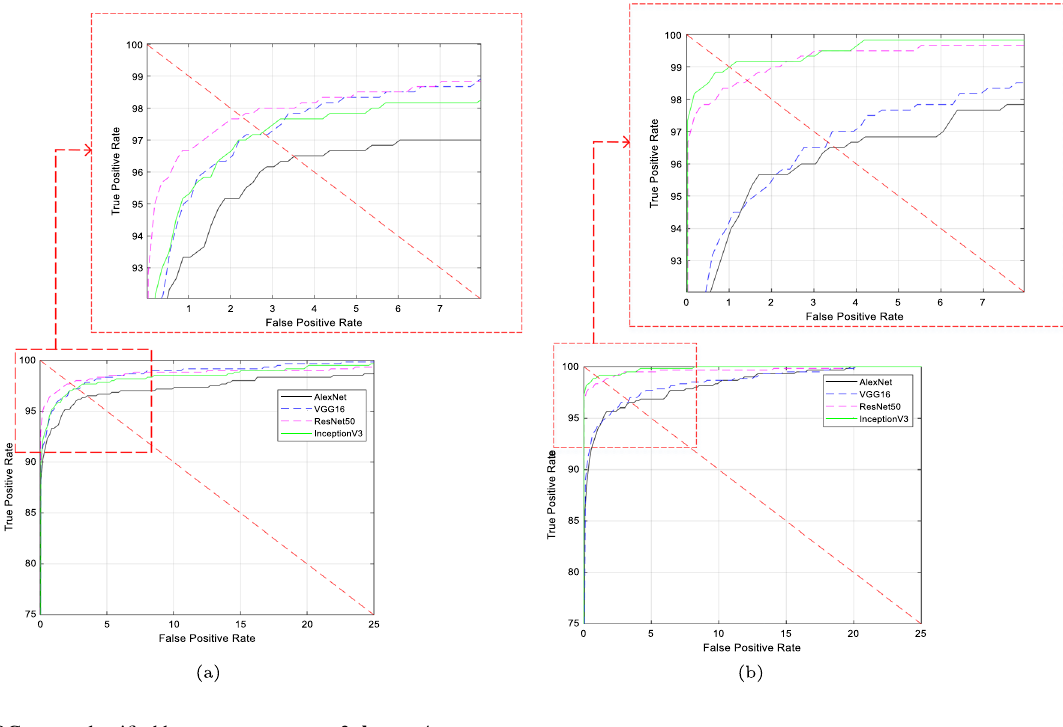
Fig. 8 ROC curve classified by two cases: a case 3; b case